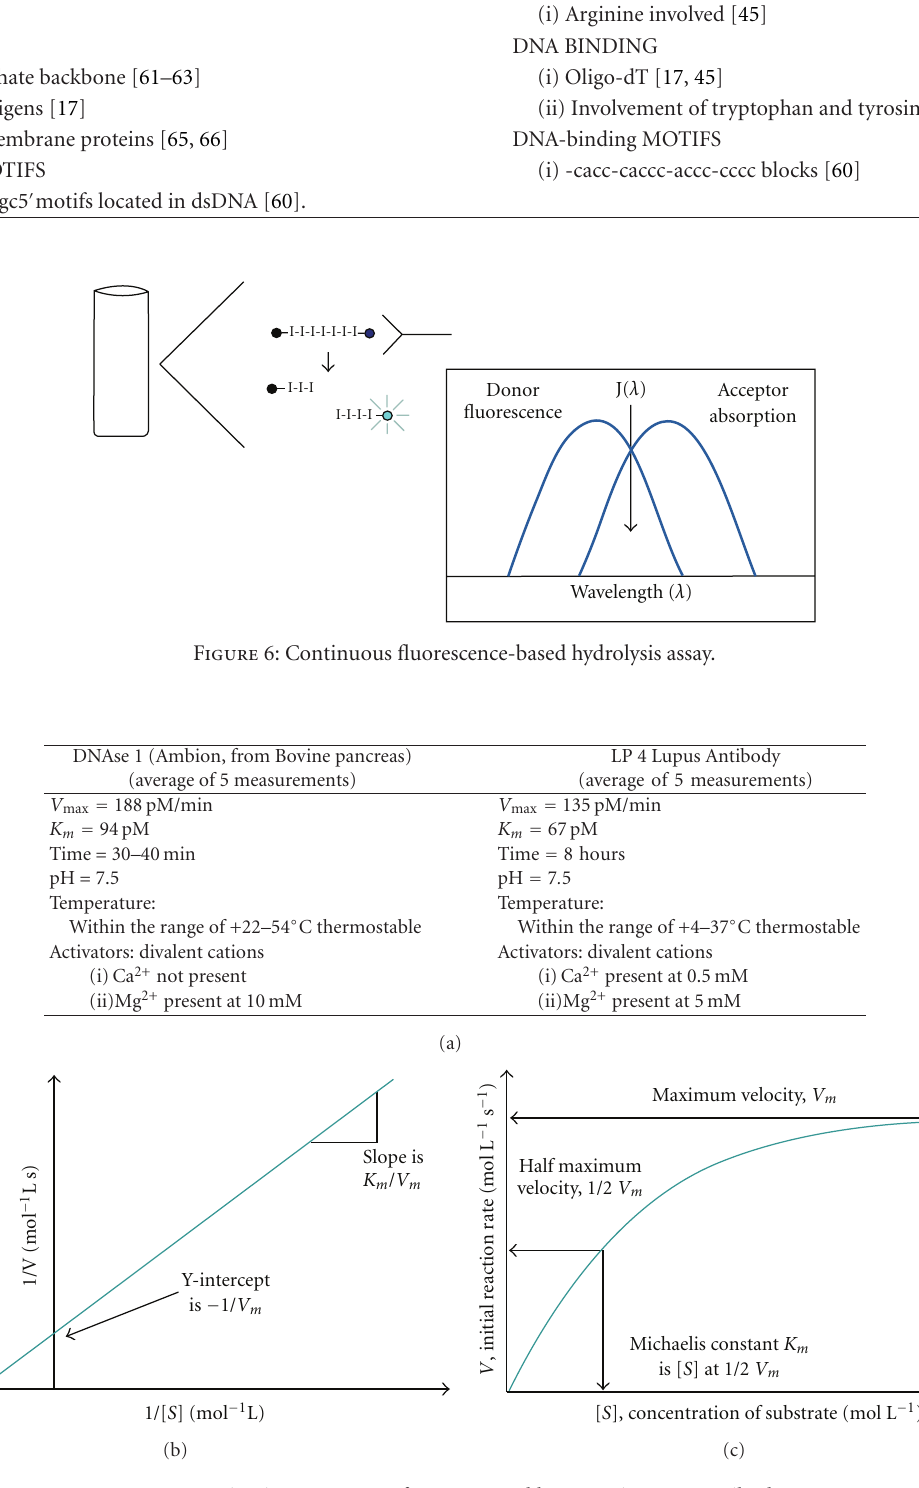
Figure 7: Kinetic parameters of DNAse 1 and lupus anti-ssDNA